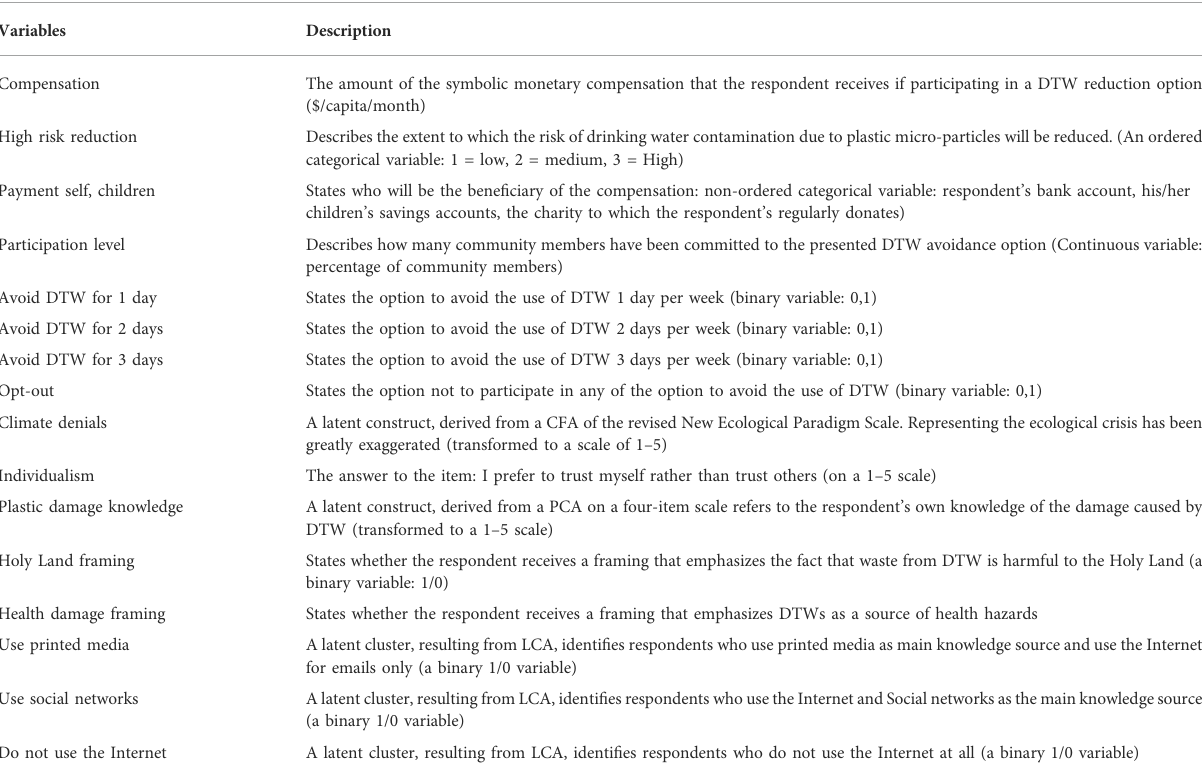
TABLE 3 Notations and assumptions used in the econometric